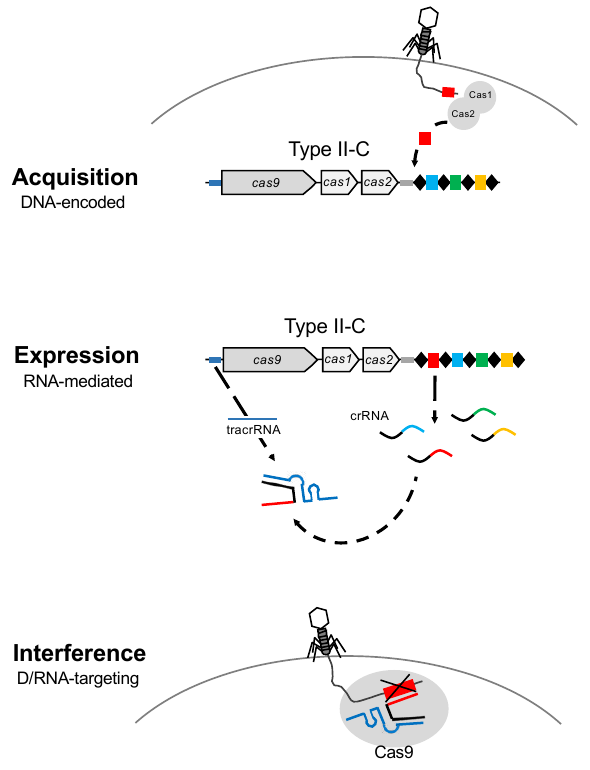
Figure 2. CRISPR-Cas systems: Mode of action. CRISPR-Cas are DNA-encoded, RNA-mediated nucleic acid targeting systems that operate via a three step process. The first step is acquisition, where Cas1 and Cas2 proteins copy and paste a short sequence of the invasive DNA which is added as a new spacer at the 5 (cid:48) end of the CRISPR array, close to the leader region. During expression, the second step, the CRISPR array is transcribed to generate the mature CRISPR RNAs (crRNA), which are the repeat-spacer pairs, and the trans-activated CRISPR RNA (tracrRNA). Finally, the interference stage is mediated by the duplex crRNA:tracrRNA that drives the Cas9 protein towards the complementary sequence of the spacer in the invasive nucleic acid to bind and cleave DNA after PAM